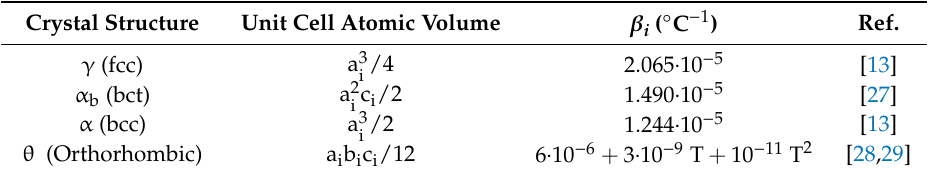
Table 2. Atomic volume and thermal expansion coe ffi cients of the di ff erent phases used in this work where a i , b i , and c i are the lattice parameters and β i represents the thermal expansion coe ffi cients. Crystal Structure